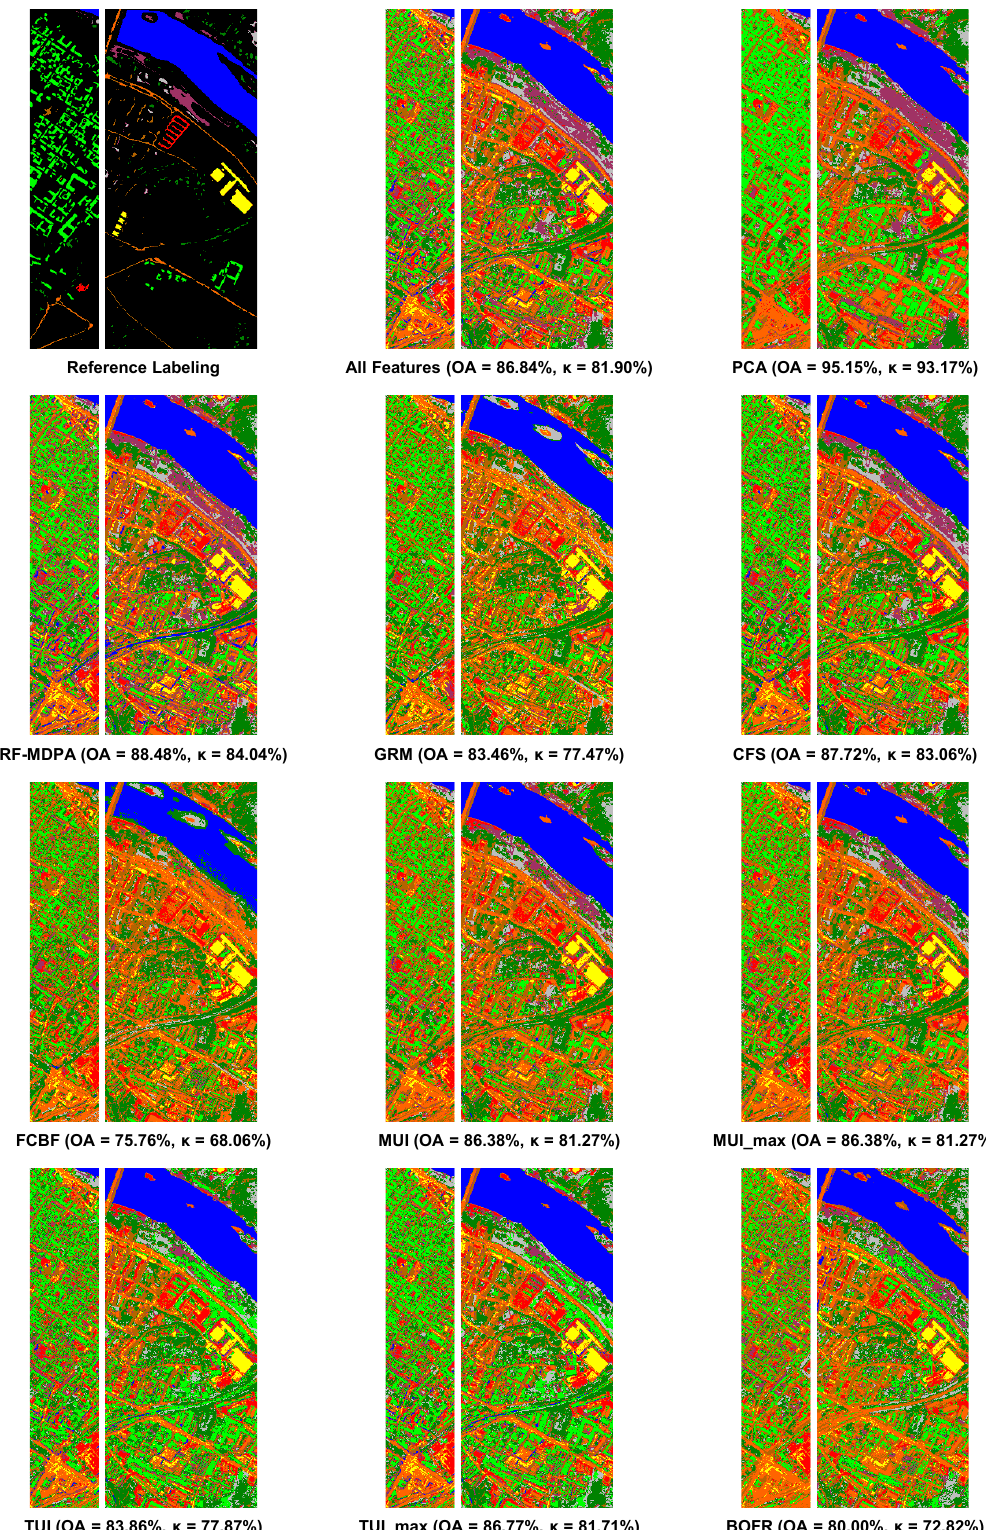
Figure 10. Classified scene for the Pavia Centre dataset when using the RF classifier and different feature sets. The values in brackets refer to the evaluation on the test